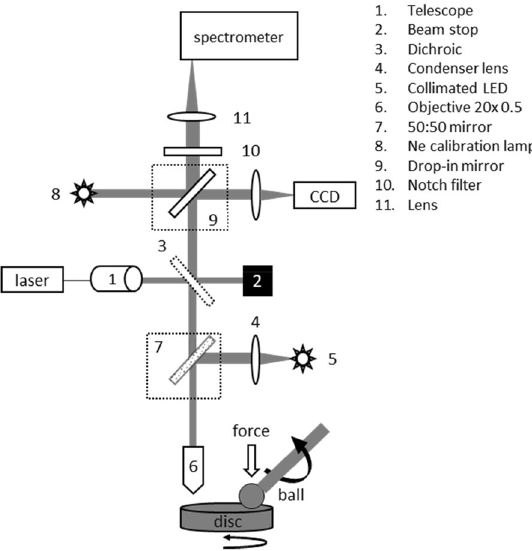
Figure 1. Schematic of the in-situ Raman apparatus.